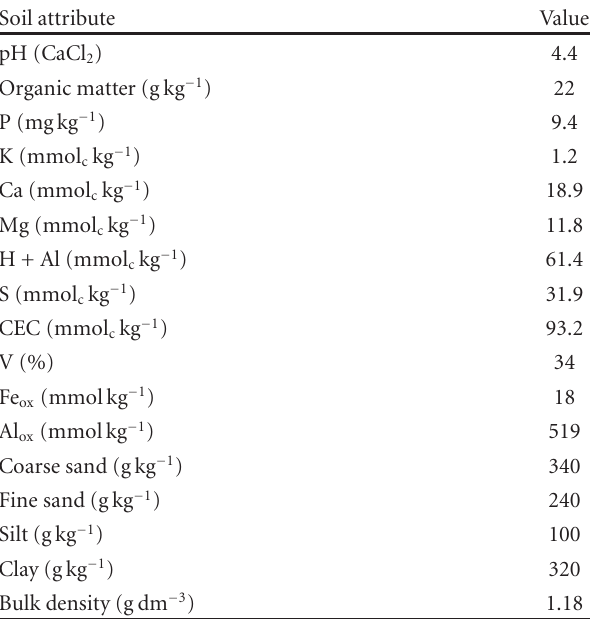
Table 1: Selected chemical and physical characteristics of the stud- ied